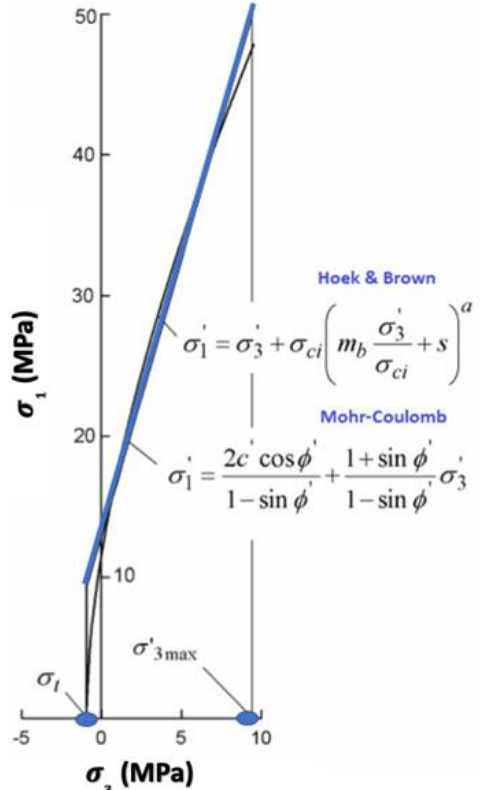
Figure 2. Relationships between the major and minor principal stresses for the Hoek-Brown and equivalent Mohr-Coulomb criteria [1].